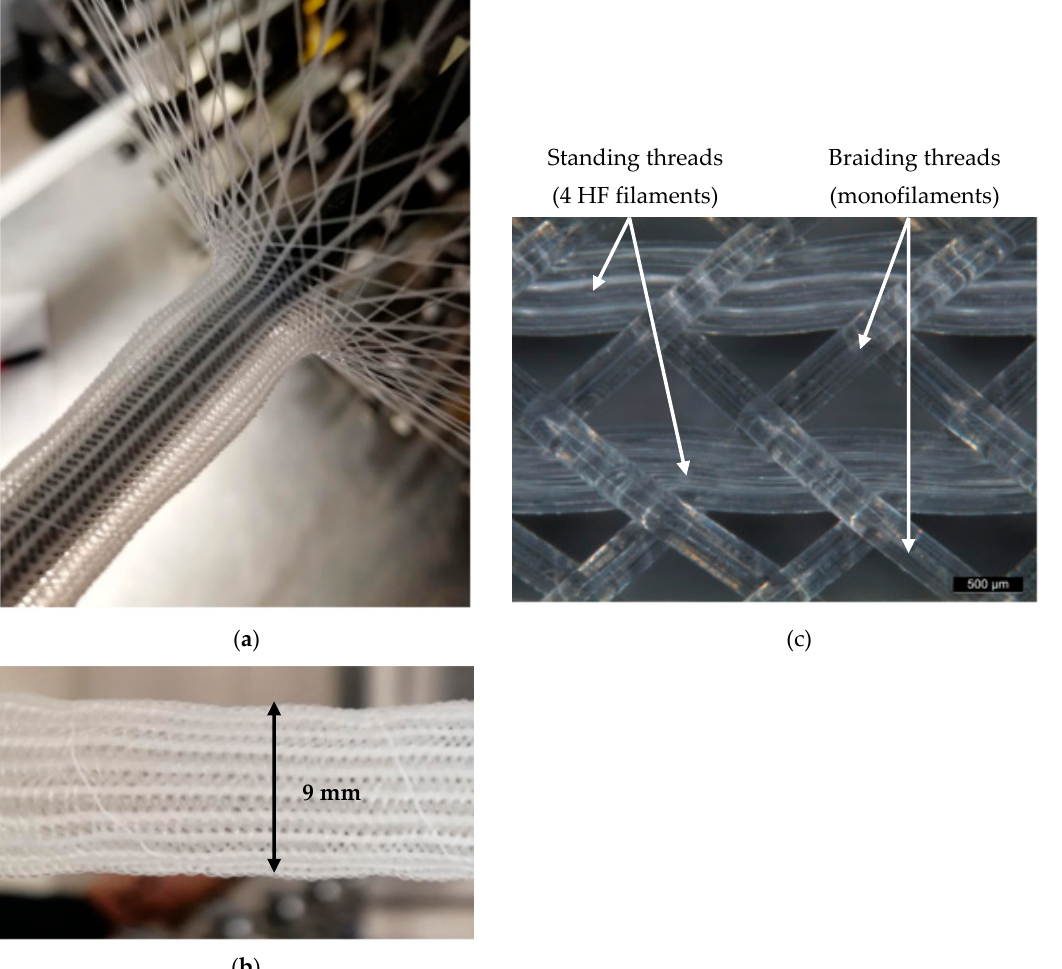
Figure 3. ( a ) Preparation of 3D structured HF fabrics via triaxial braiding; ( b ) braided hose; ( c ) structure of braided HF hose with medium braiding angle.